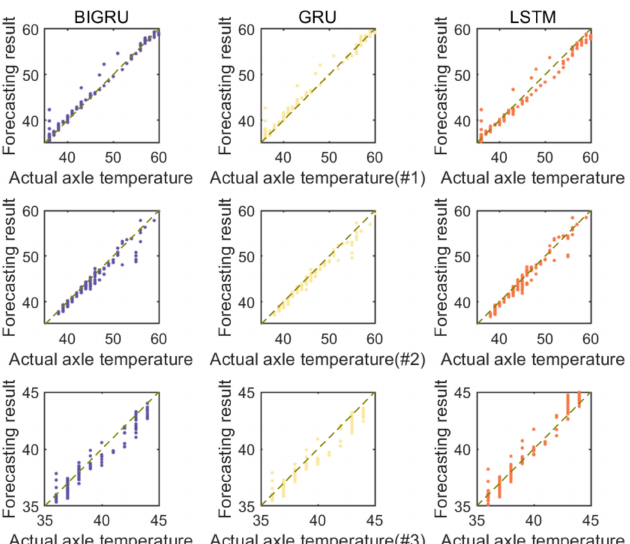
Figure 8. Scatter plots of BIGRU, GRU, and LSTM.